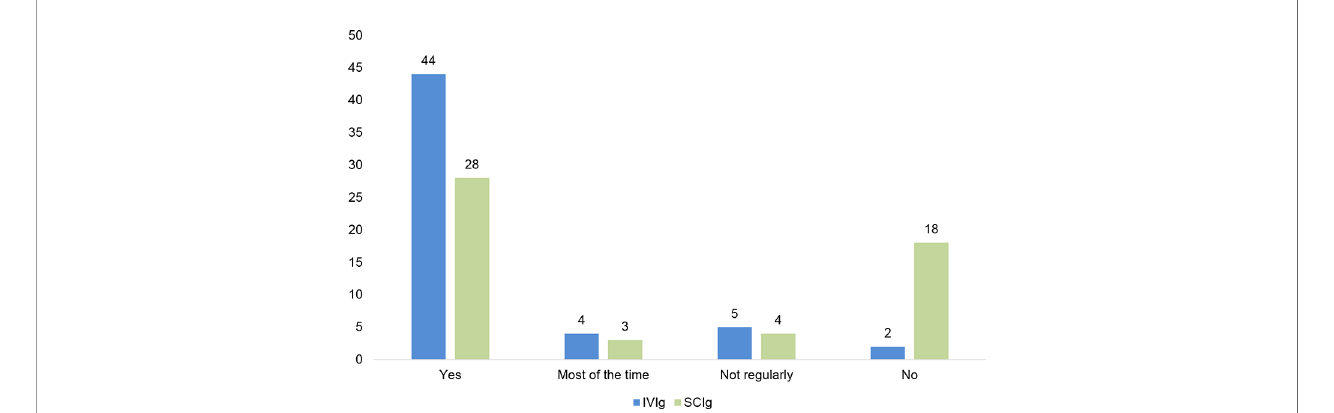
FIGURE 3 | IVIg (n=55) and SCIg (n=53) availability at national